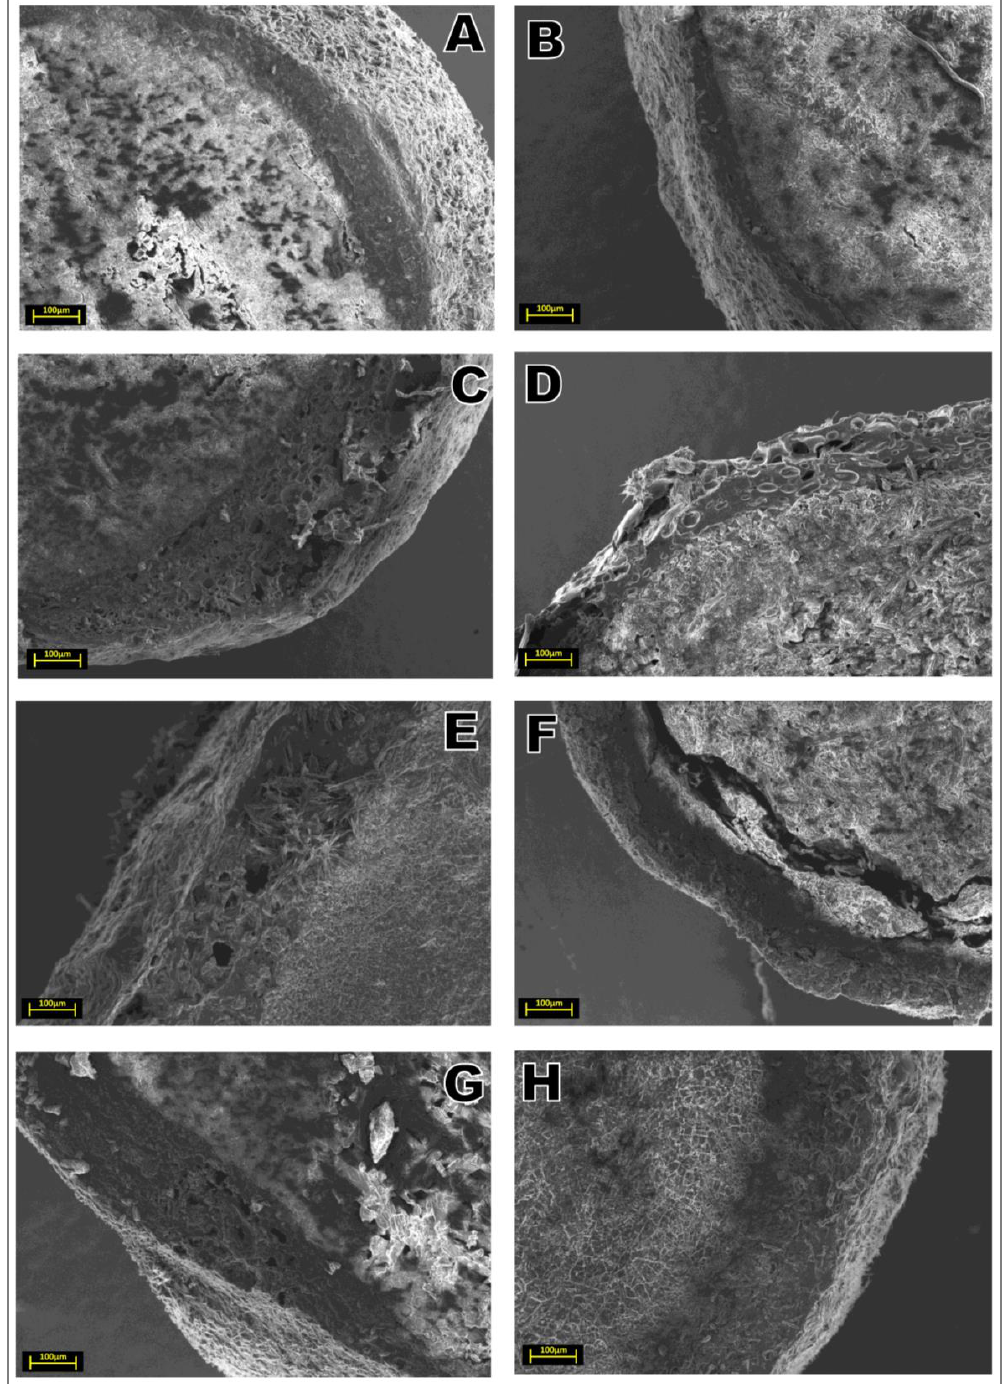
Figure 2. Field emission scanning electron microscope (FESEM) micrographs of representative cross-sections of coated granules.